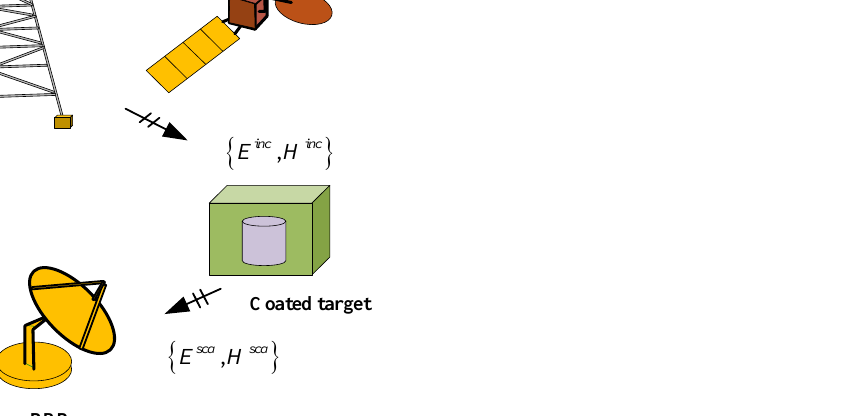
tric conductor, dielectric region, and background medium region. The surface of dielectric and perfect electric conductor is denoted by represents the